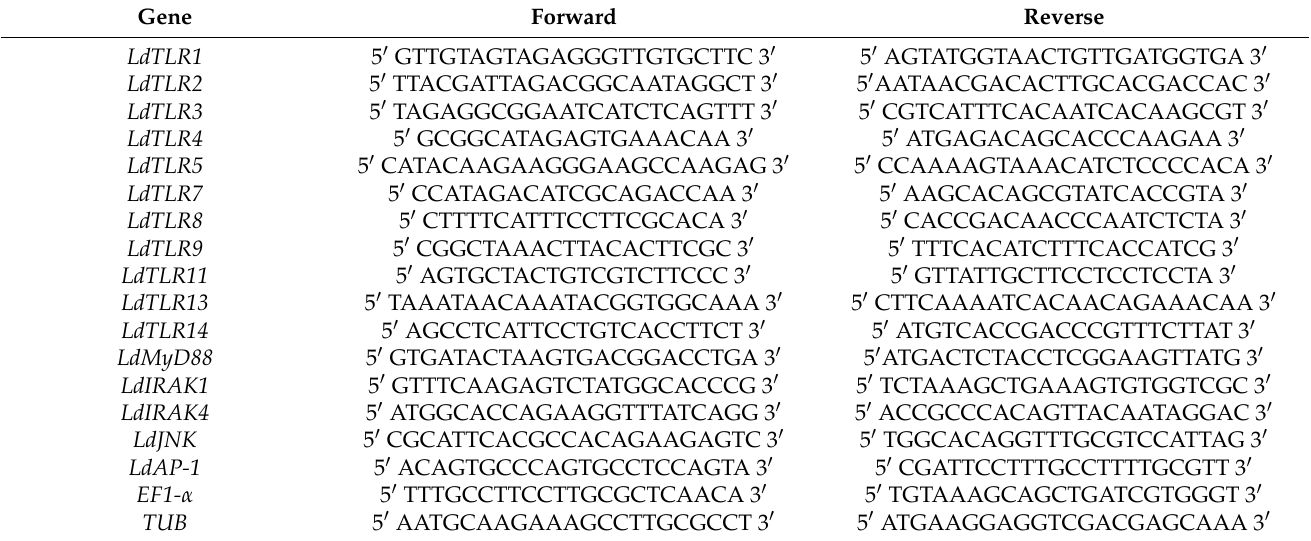
Table 1. Sequences of the primers for